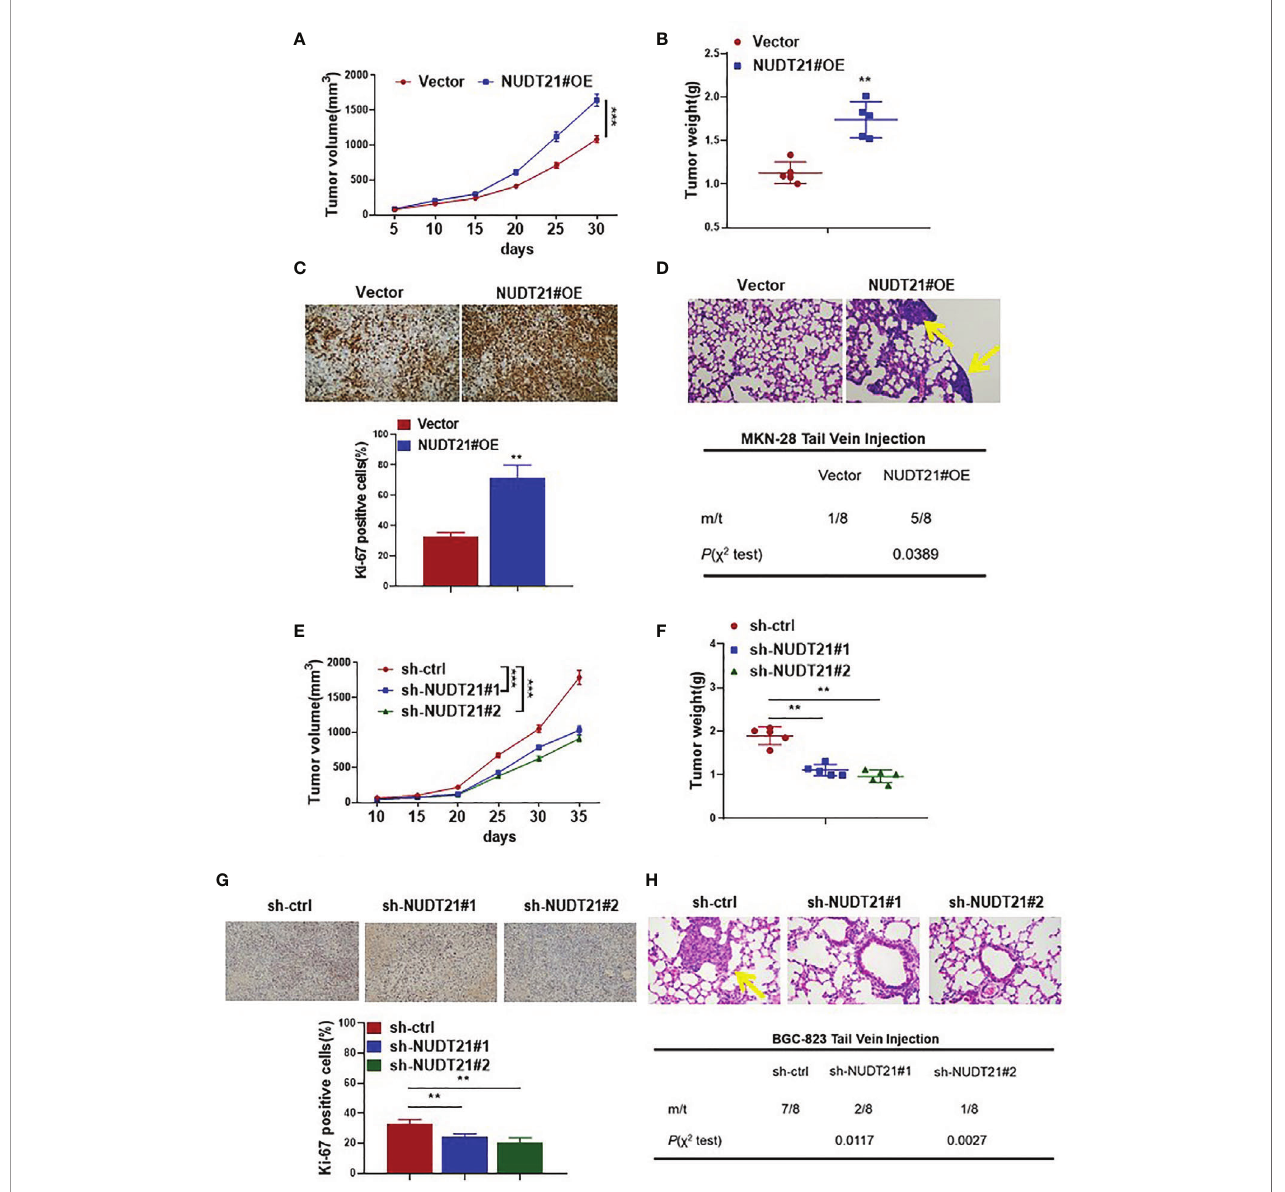
FIGURE 3 | NUDT21 promoted tumor growth and metastasis of gastric cancer cells in nude mice. MKN-28-NUDT21#OE/MKN-28-Vector cells and BGC-823-sh- ctrl/BGC-823-sh-NUDT21#1/BGC-823-sh-NUDT21#2 cells were subcutaneously injected into the dorsal side of nude mice. Each group contained 6 mice. (A, E) Tumor volumes were evaluated every 5 days for 30 days, and tumor growth curves were analyzed. (B, F) Weights of the tumors were measured. (C, G) Ki-67 staining in xenograft tumor sections by immunohistochemistry. MKN-28-NUDT21#OE/MKN-28-Vector cells and BGC-823-sh-ctrl/BGC-823-sh-NUDT21#1/BGC- 823-sh-NUDT21#2 cells were injected into the venous circulation of nude mice. Each group contained 8 mice. After about 40 days, the mice were sacri fi ced and their lungs were collected. (D, H) Hematoxylin and eosin staining of lung sections. The arrows pointed to tumor micrometastasis. Lung metastasis of tumor in these mice was calculated. ** P < 0.01; *** P <